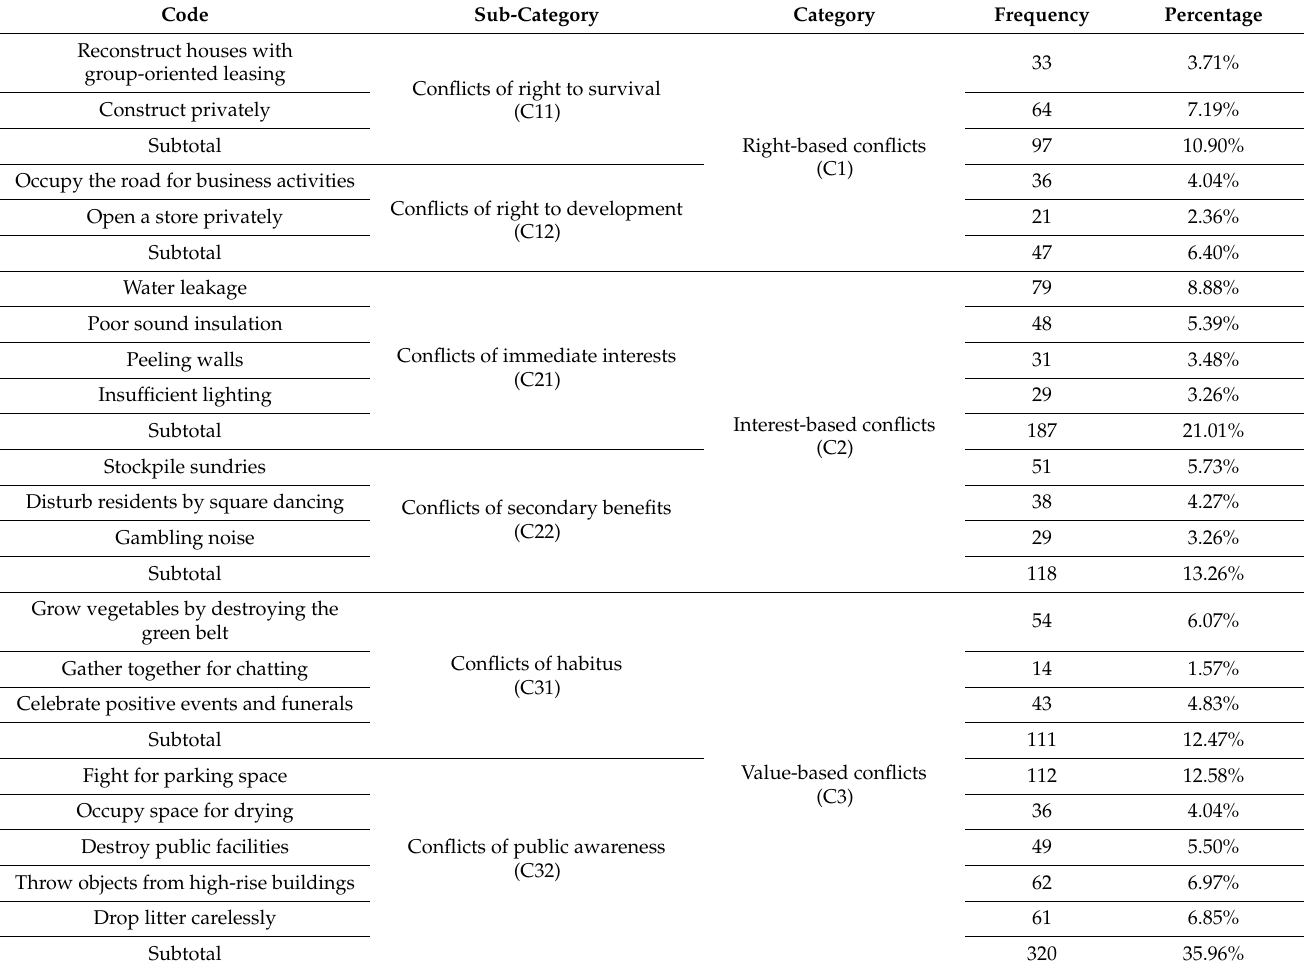
Table 3. The distribution characteristic of RCC